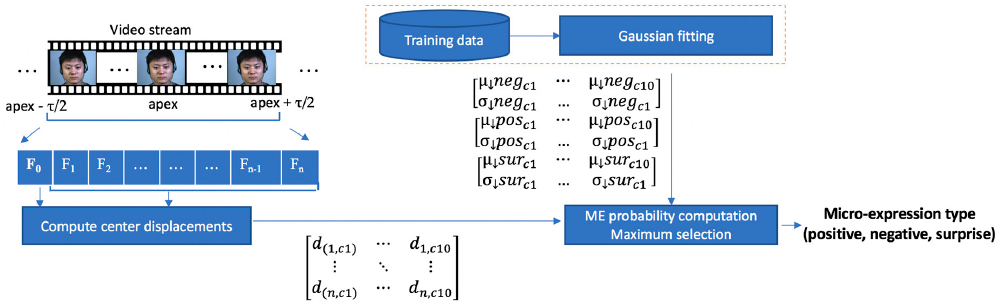
Figure 9. ME recognition module.